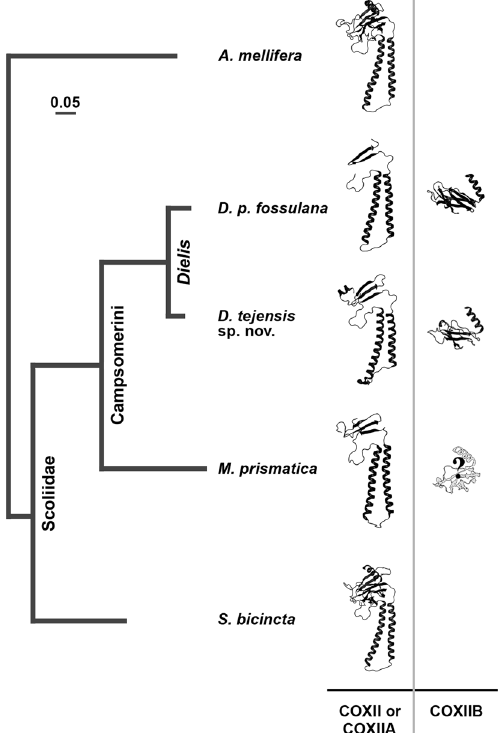
Figure 7. Graphical synopsis of the evolution of cox2 dimorphism in Scoliidae. The phylogram depicts the maximum likelihood genealogy of the cox2a gene or a corresponding region in undivided cox2 (GTR distance). The “?” refers to the unknown location of the cox2b